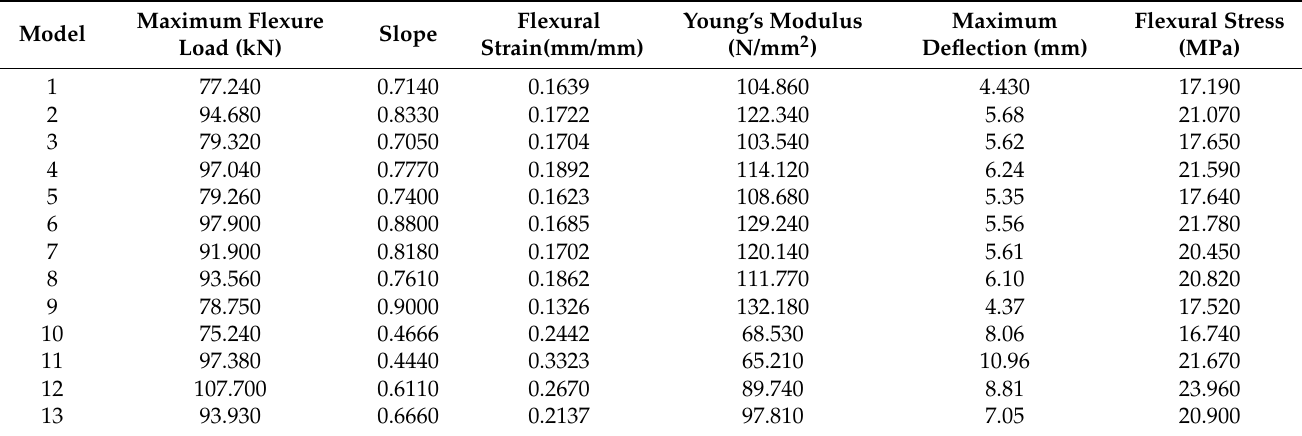
Table 4. Experimental results and the outputs for the